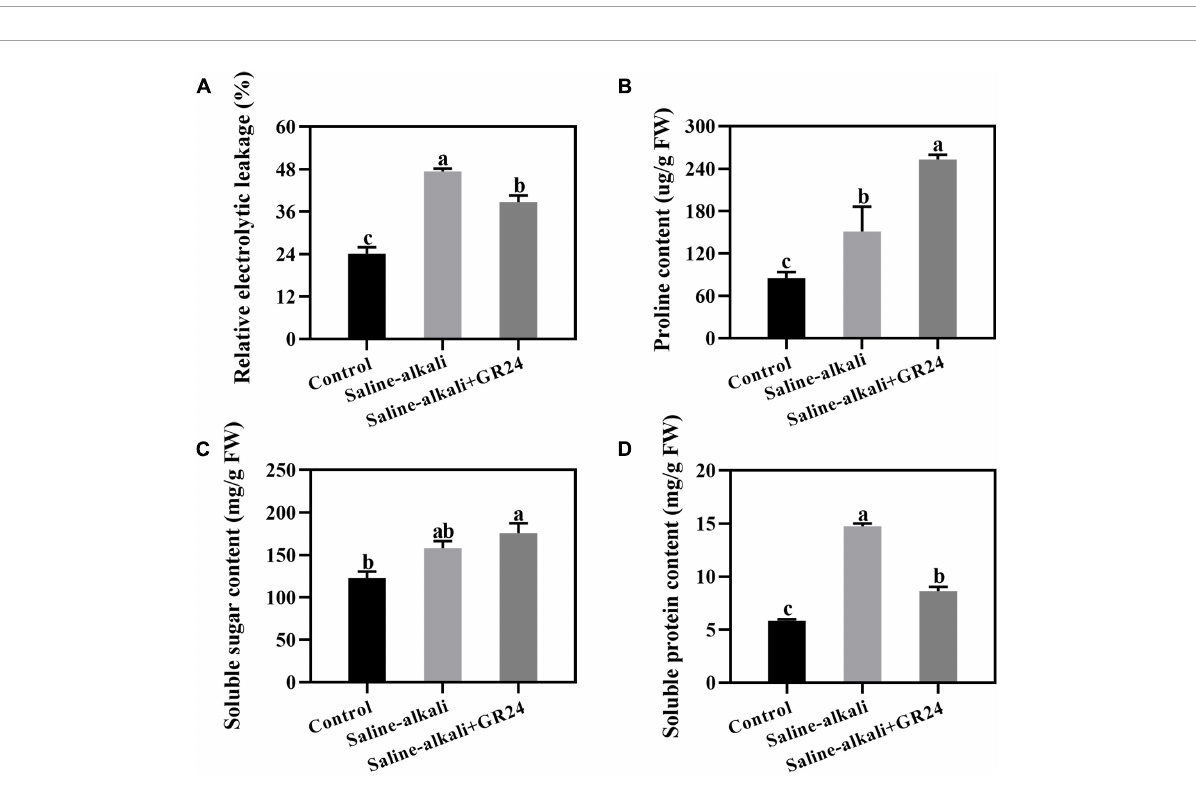
FIGURE4 Effects of exogenous GR24 treatment on electrolyte leakage (A) , proline content (B) , soluble sugar content (C) , and soluble protein content (D) under salinity-alkalinity stress. The data represent the mean ± SD of three biological replicates. Different lowercase letters indicate significant differences according to Fisher’s least significant difference ( P <